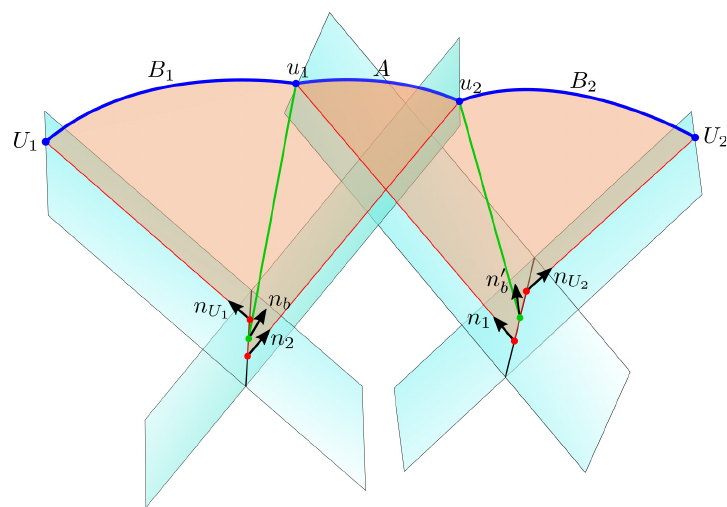
Figure 10: Construction of the EWCS for a single interval in flat-space TMG. The green line segments show only a schematic view of the actual EWCS which for the case of two adjacent intervals, require a specific regularization scheme in terms of extra null geodesics dropping from the common boundary. Note that there will be additional bulk timelike vectors on each of these extra null geodesics which come into the calculation of the